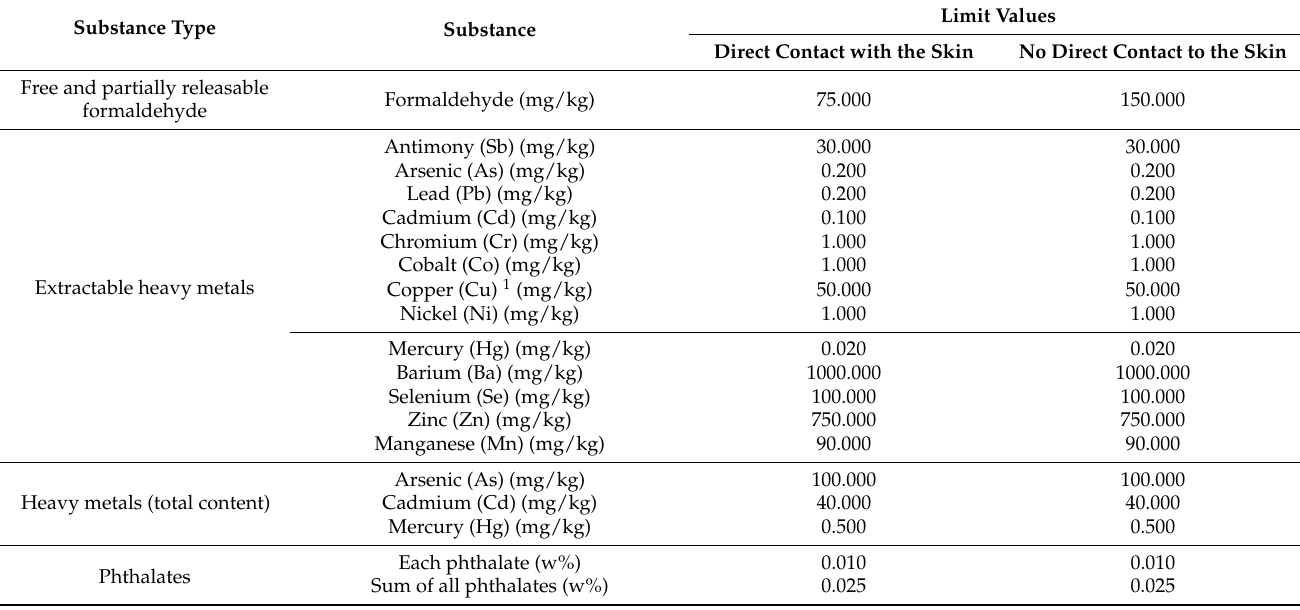
Table 1. Limit values for different harmful substances specified by OEKO-Tex (examples)